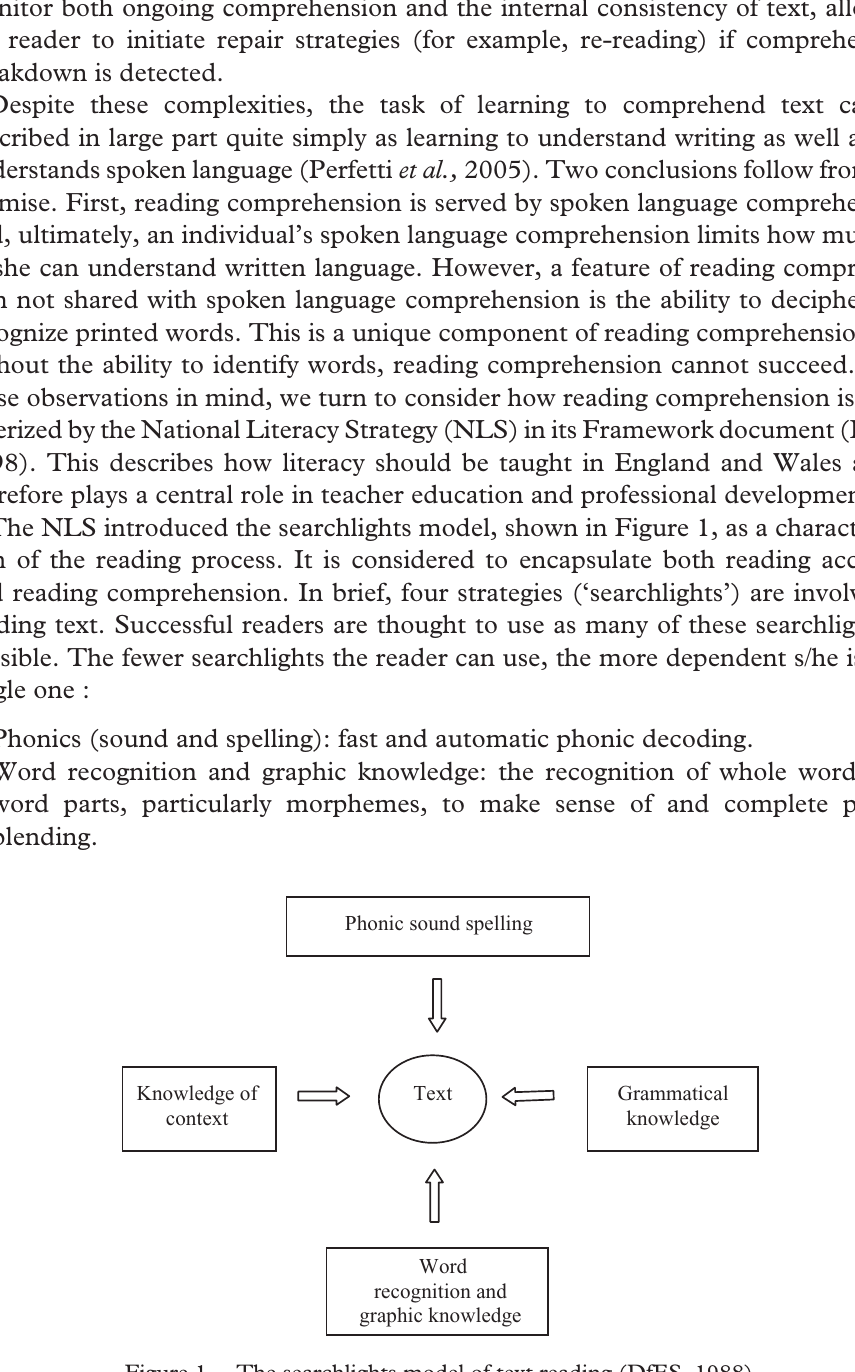
Figure 1. The searchlights model of text reading (DfES,